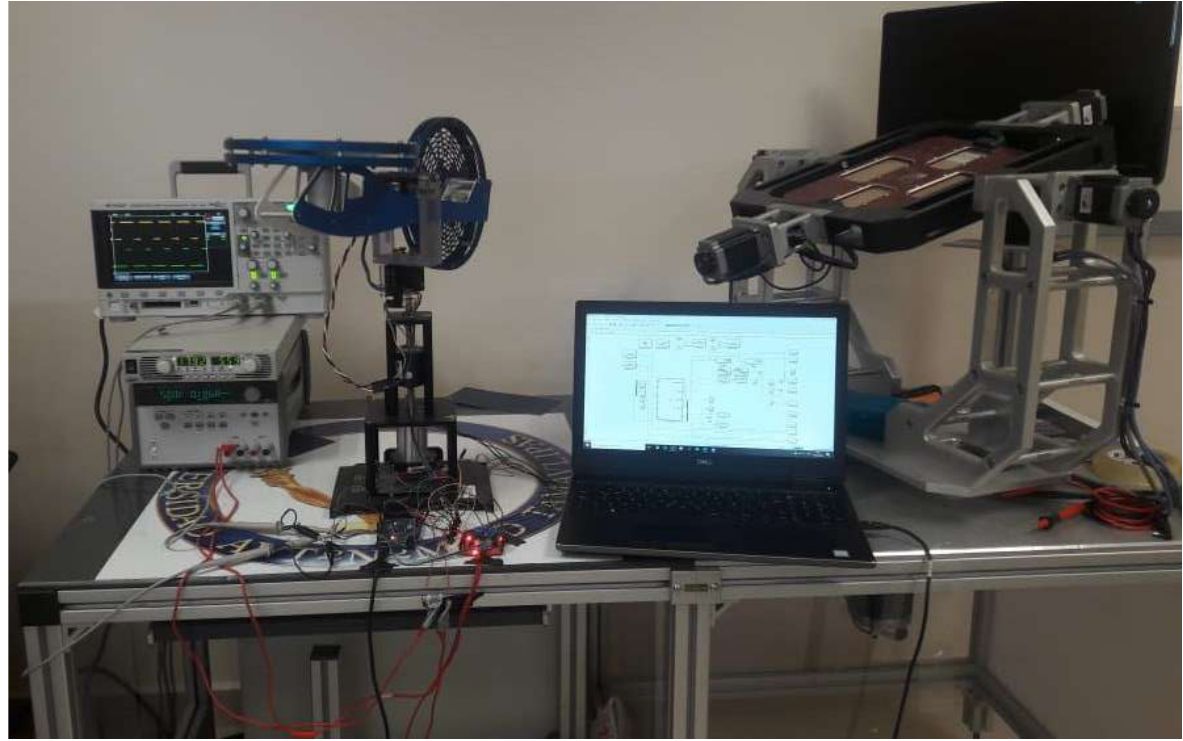
Figure 9. Experimental platform of the 2-DOF helicopter closed-loop control